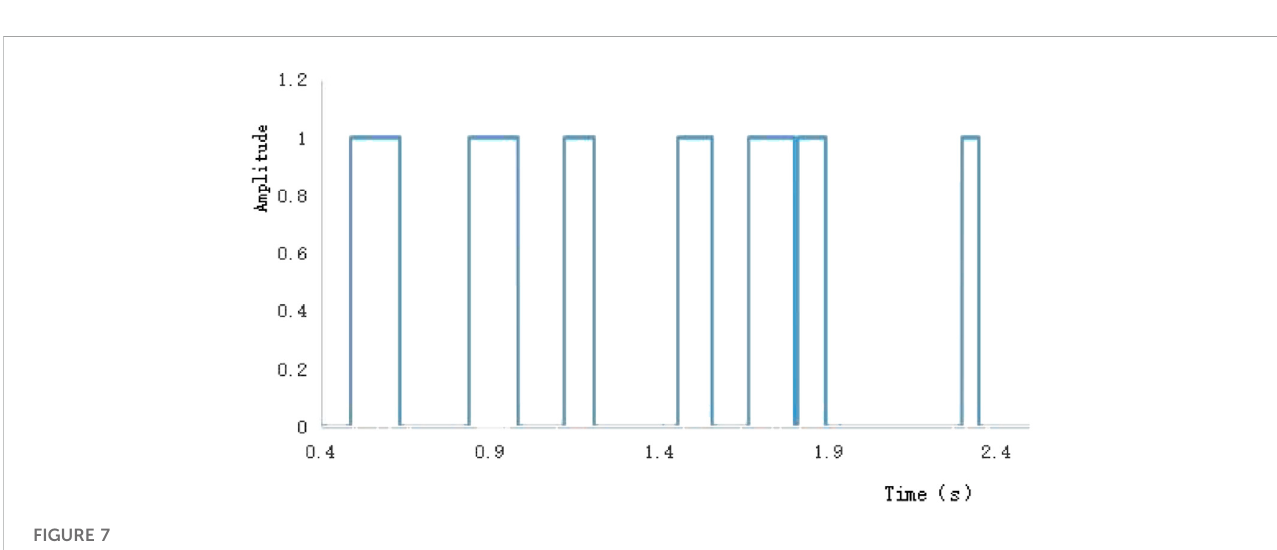
FIGURE 7 Rectangular